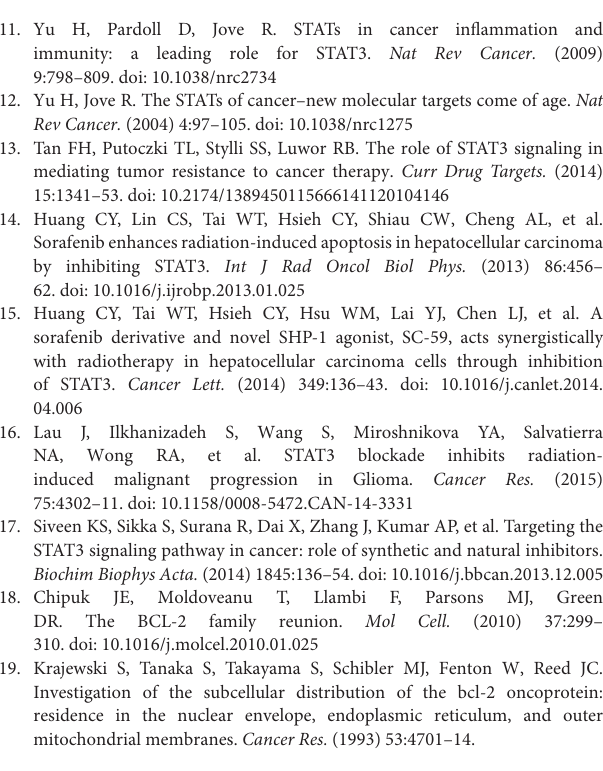
Supplementary Figure 1 | Radioresistance caused by signaling pathways related to STAT3. Radiation induced anti-apoptosis is mediated by STAT3-HSP70-BCL2 family members pathways. After radiation treatment, STAT3 promoted aggressive behaviors in tumor cells through epithelial–mesenchymal transition (EMT), radiation-induced bystander effect (RIBE) and tumor microenvironment (TM). STAT3 contributes to DNA damage repair through ATM-Chk2 and ATR-Chk1 pathways. Cancer stemness and reactive oxygen species (ROS) depletion are also involved in STAT3-induced